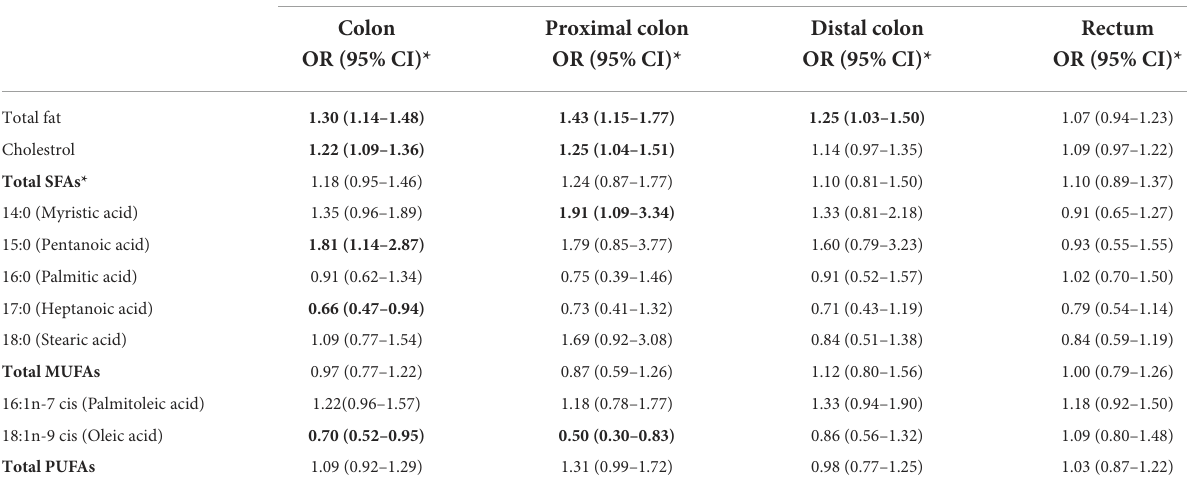
TABLE 3 Odds ratios and 95% confidence intervals of colorectal cancer and specific fatty acids intakes stratified by colorectal tumor